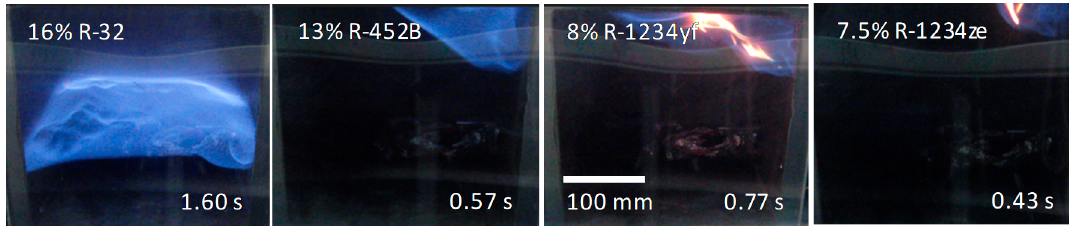
Figure 4. Images from butane flame insertion tests corresponding to the largest flame for each test. The times shown are elapsed times after the onset of flaming. A video of these tests is provided in the Supplementary Materials Video S4.